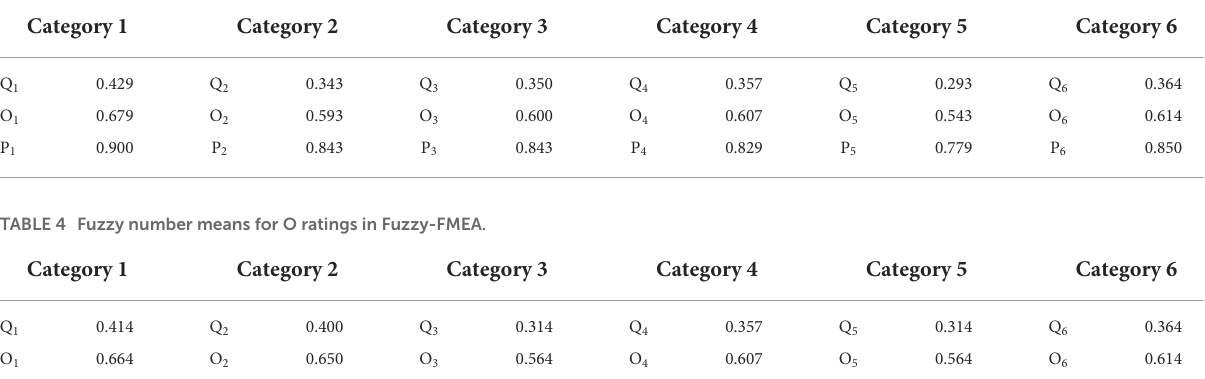
TABLE 3 Fuzzy number means for S ratings in Fuzzy-FMEA.